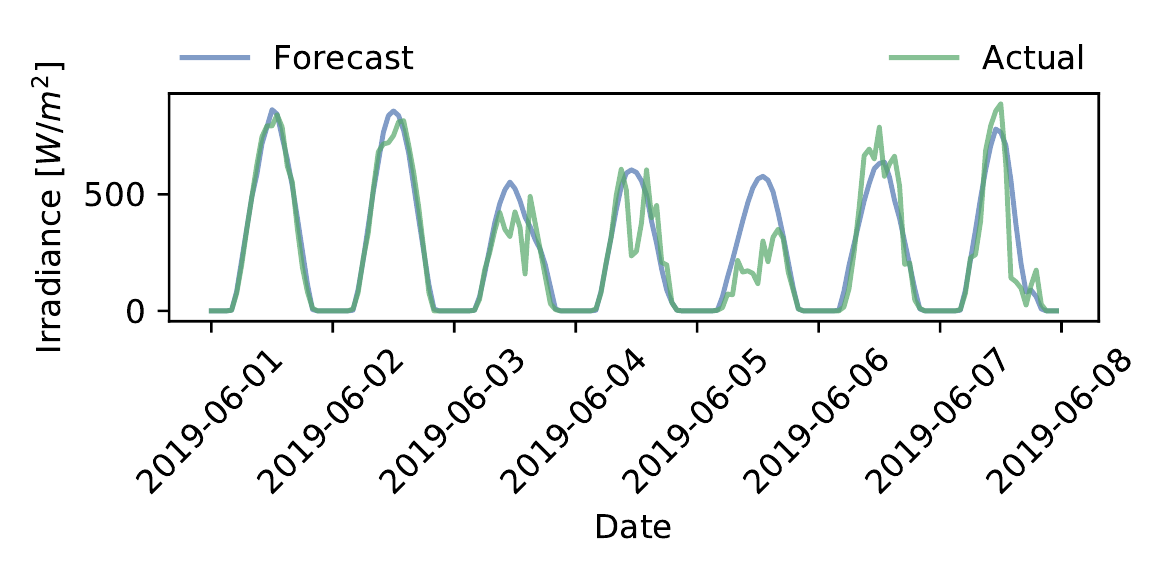
Figure 7. Comparison of forecasted and measured irradiance data during the first week of June 2019.